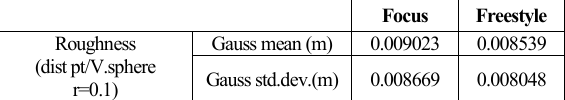
Table 4. Roughness index on portion of the point cloud